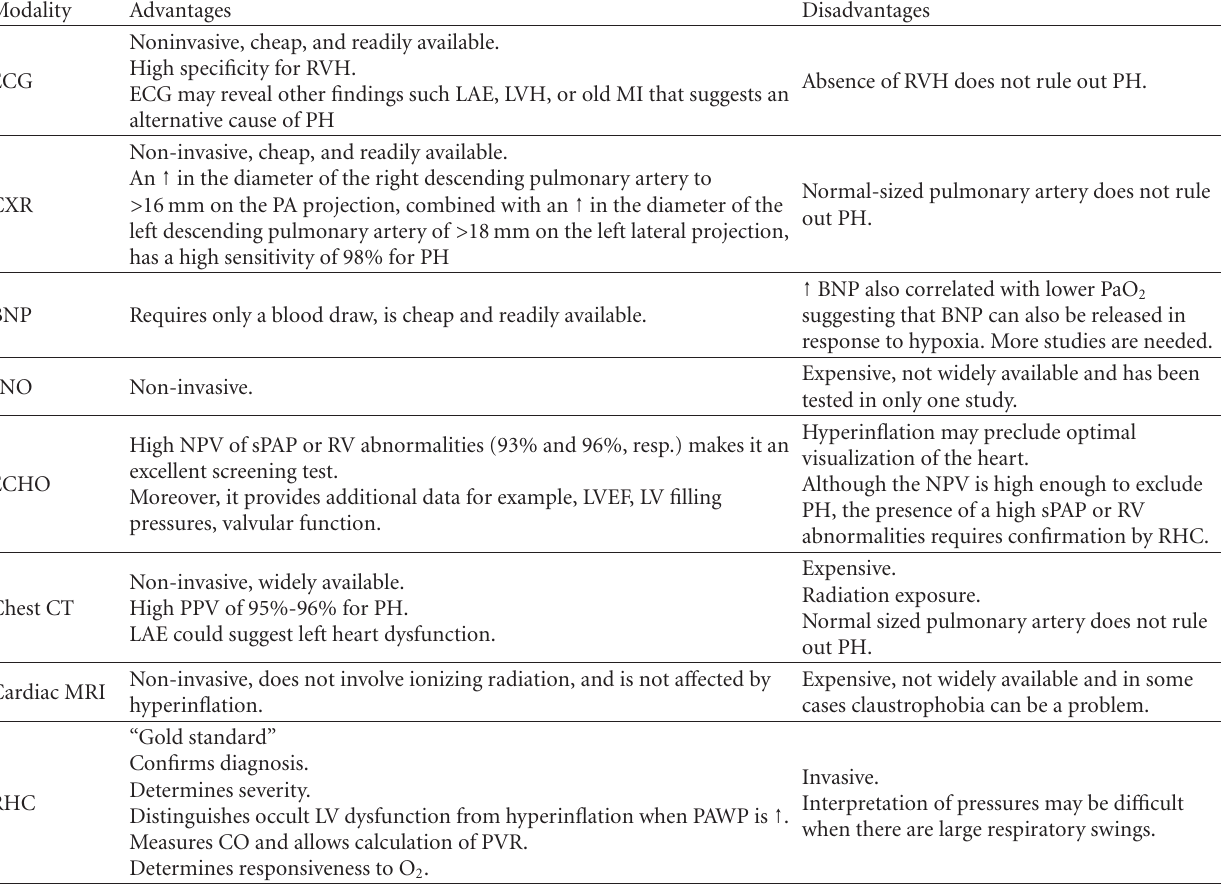
Table 3: Various approaches to the diagnosis of PH in